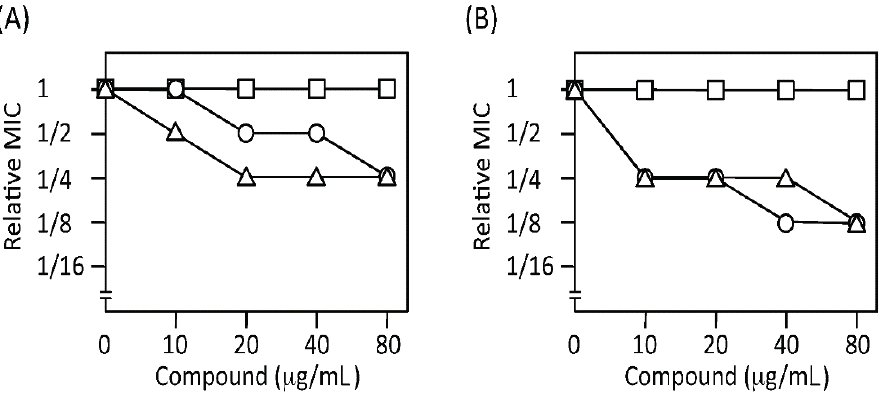
Figure 6. Synergistic effect of YH001 with antibiotics. Potentiation of the antibiotic effect with YH001 was assayed by the checkerboard method. The MIC values were expressed relative to that in the YH001-free medium. ( A ) P. aeruginosa wild type strain PAO4290. MICs of aztreonam, chloramphenicol, and imipenem in PAO4290 are 2.0, 16 and 4.0 µg/mL, respectively. ( B ) P. aeruginosa mutant TNP30#1 producing an elevated level of MexAB-OprM. MICs of aztreonam, chloramphenicol, and imipenem in TNP30#1 are 32, 64 and 4.0 µg/mL, respectively. Symbols: circles, aztreonam; triangles, chloramphenicol; and squares,